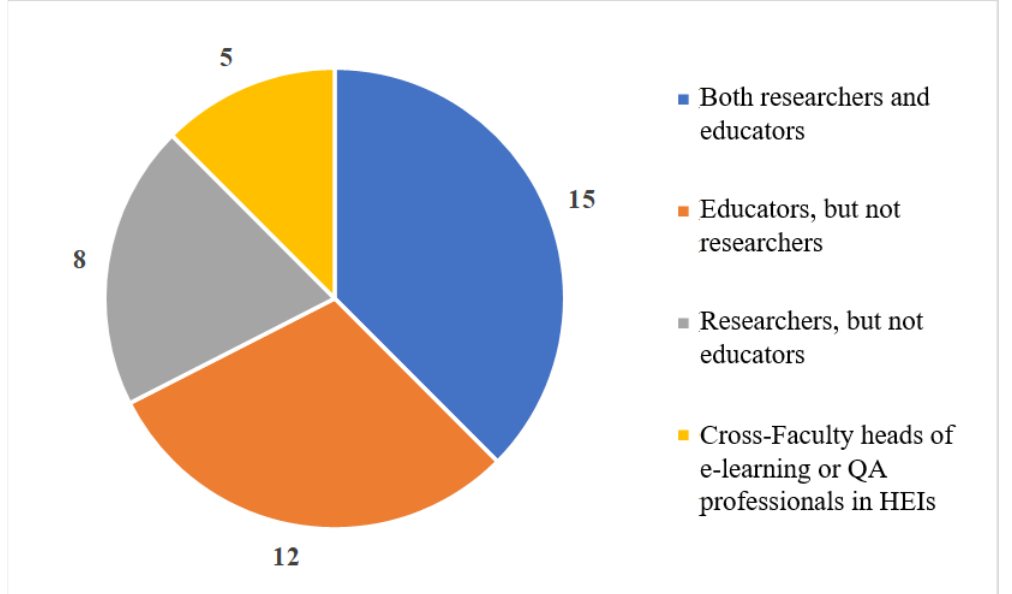
Figure 2 . Round 1 Delphi study’s experts’